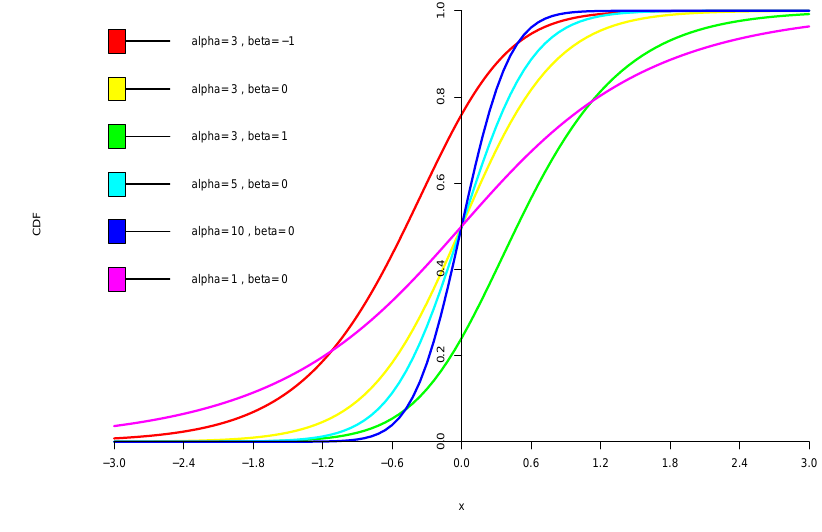
Figure 2. CDF of Hyperbolic distribution against α and β